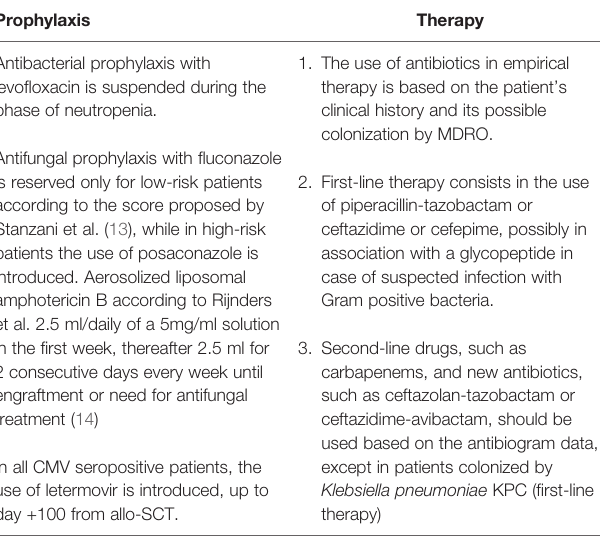
TABLE 1 | Characteristics of BATMO protocol for prophylaxis and treatment of infections in allotransplanted patients. Prophylaxis Therapy Antibacterial prophylaxis with levo fl oxacin is suspended during the phase of